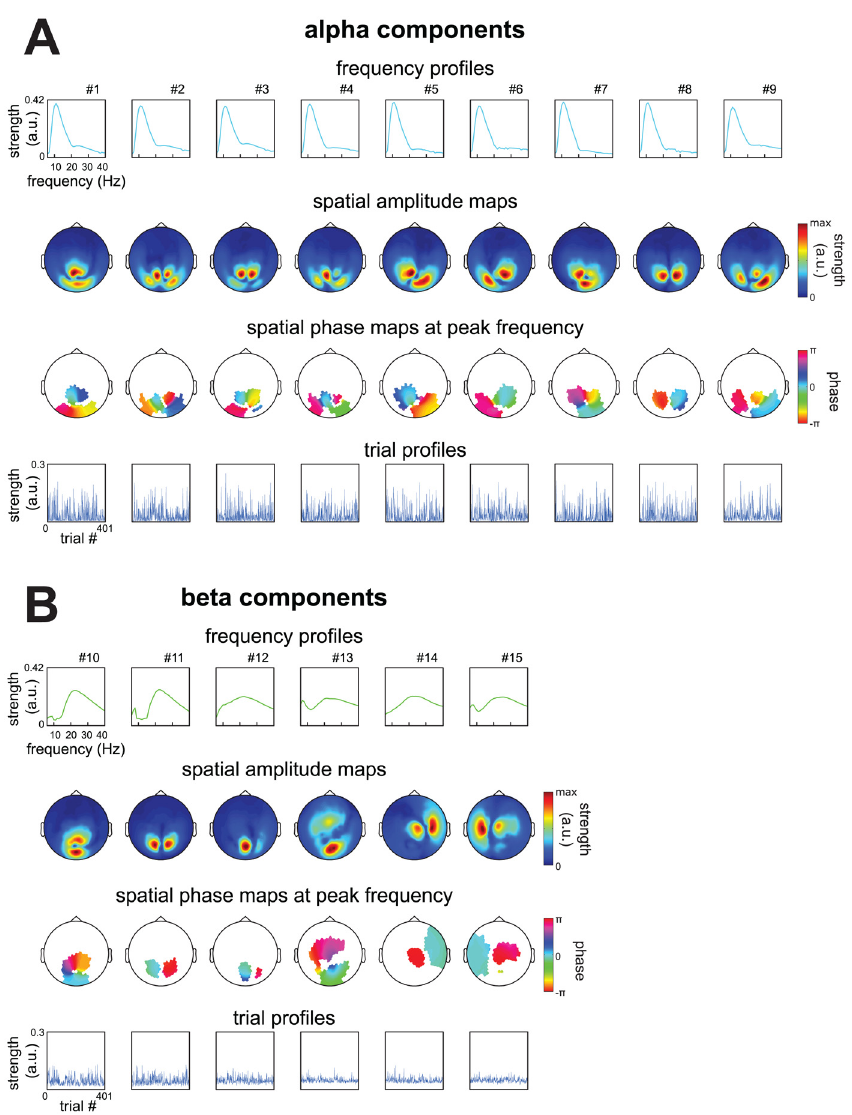
Fig 4. Spatial and spectral structure of sources described by 15 components from a representative subject. We extracted 15 components using the analysis pipeline described in Materials and Methods from MEG recordings of a representative subject performing a cued tactile detection task (see Materials and Methods). This dataset came from the prestimulus period. A , frequency profiles, spatial amplitude maps, spatial phase maps at the peak frequency, and trial profiles of components reflecting alpha sources. Phases in the spatial phase maps were masked when amplitudes in the spatial amplitude map fell below 30% of its maximum. B , same as A, but for components reflecting beta sources. The components we extracted consisted of (1) many overlapping posterior alpha components, (2) posterior beta components, (3) an occipito-central/frontal component and (4) left and right sensorimotor beta components. Components reflected different types of sources, for a discussion see Results and Sections 1,2 and 3 in S1 File.